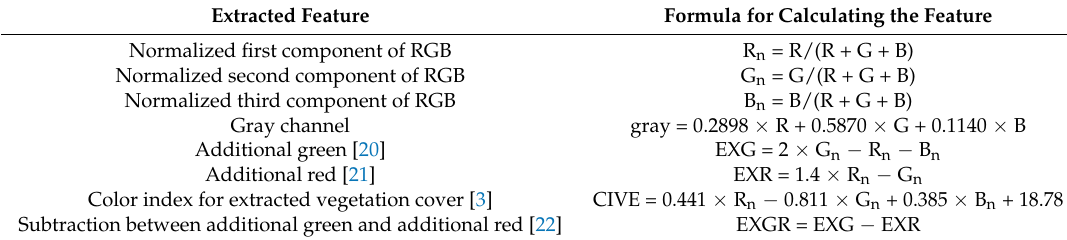
Table 2. Color features extracted for each pixel, related to vegetation indices. R n , G n , and B n refer to normalized red, green, and blue,